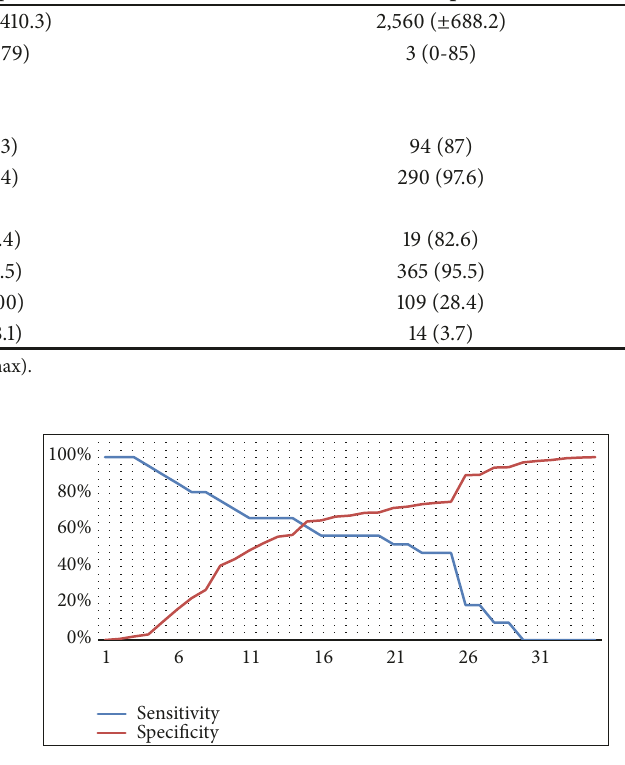
Figure 1: Cut-off point of duration from PROM to hospital admis- sion in all PROM cases (18